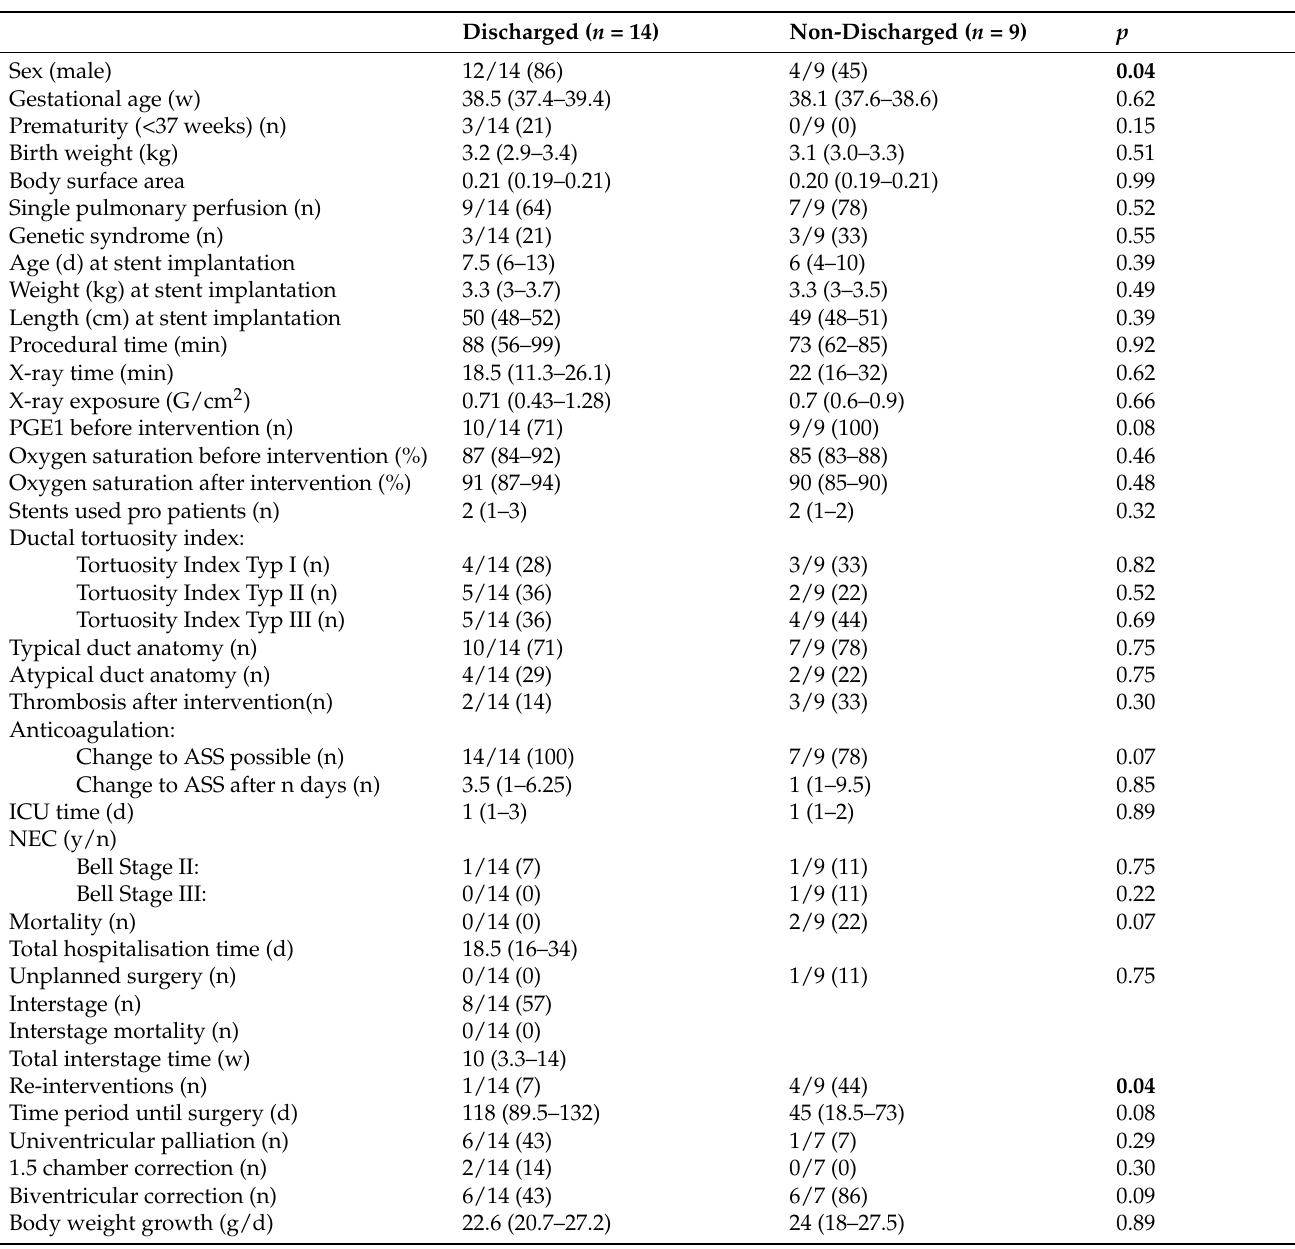
Table 2. Comparison of discharged and non-discharged infants after PDA-stenting during short- to mid-term follow-up until subsequent surgical